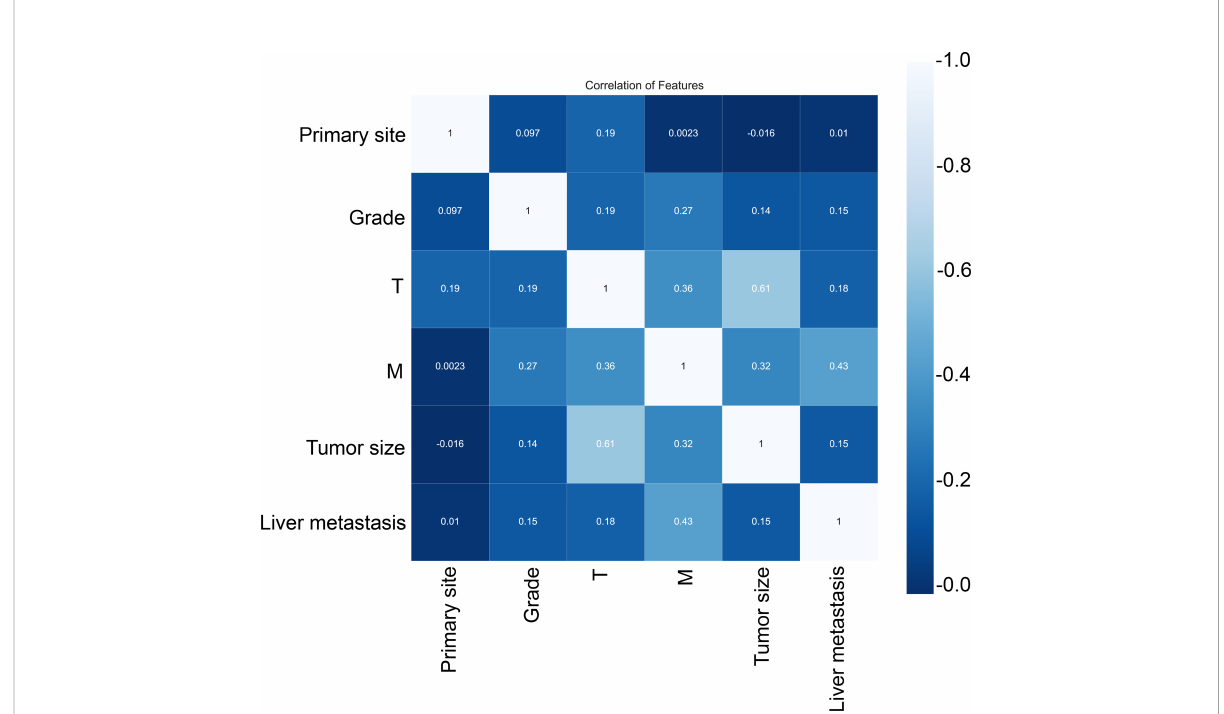
FIGURE 4 Correlation of variables. These variables were independent of each other with no signi fi cant correlation and no collinearity.